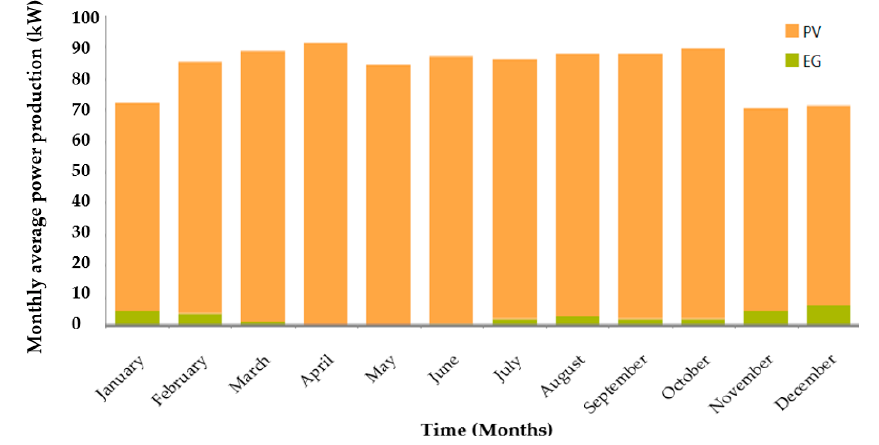
Figure 17. Share of power production EG + PV + BES based power supply system configuration [Note: EG-Electric grid; PV-Photovoltaics; BES-Battery energy storage]. Table 8. Techno-economic and environmental indicators of EG + PV + BES based power supply system considering only REUs load.